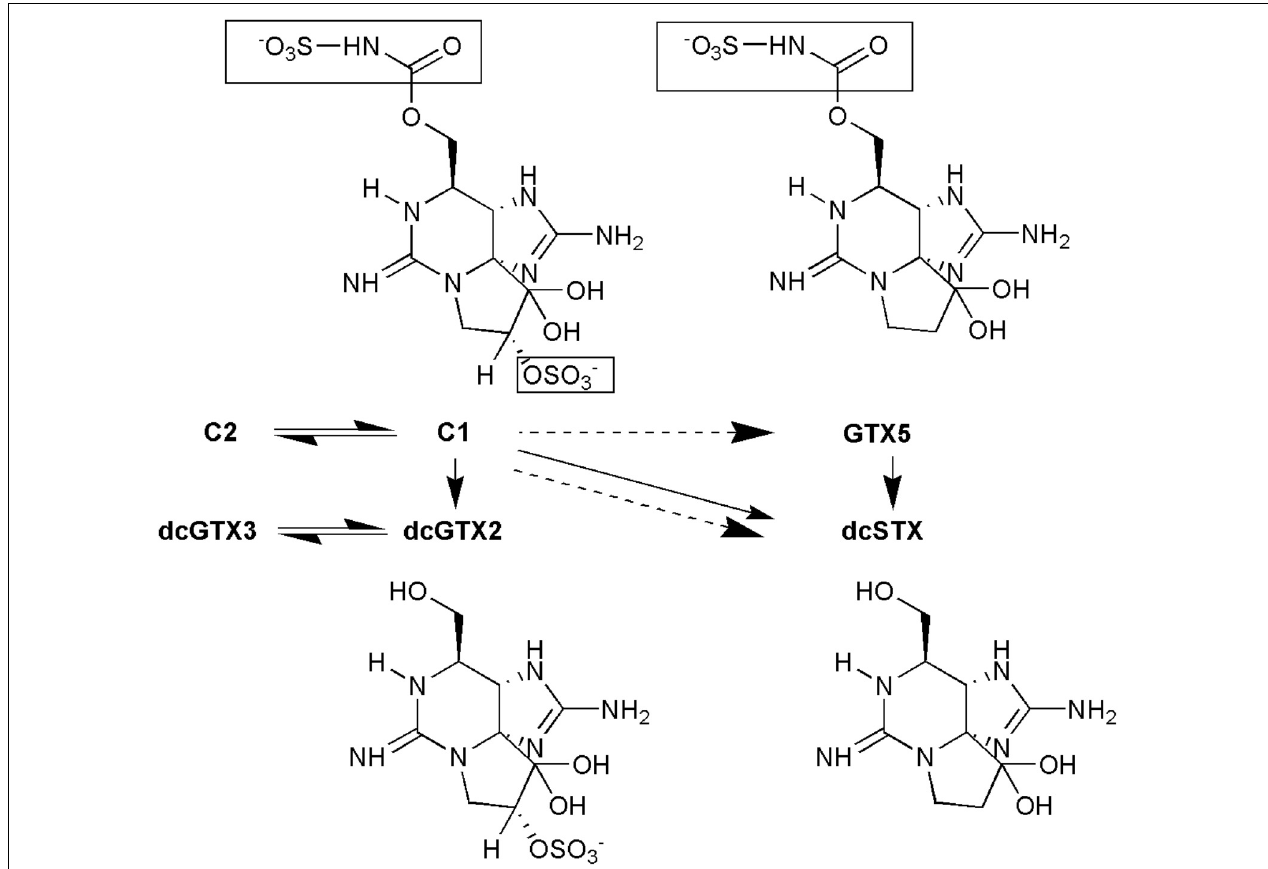
FIGURE 6 | Diagram of assumed biotransformations that occurred in viscera of geoduck Panopea globosa contaminated with Gymnodinium catenatum paralytic shellfish toxins. The part of the molecule that is modified to become in another analog is highlighted in a square. Solid arrow: desulfo-carboxylation, dashed arrow: desulfurization, double arrow: